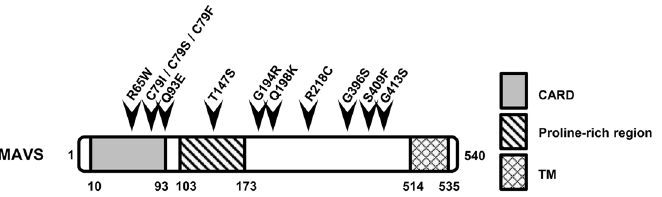
Fig 1. SNPs selected in this study. Schematic diagram of the conserved domains of MAVS and the locations of SNPs.